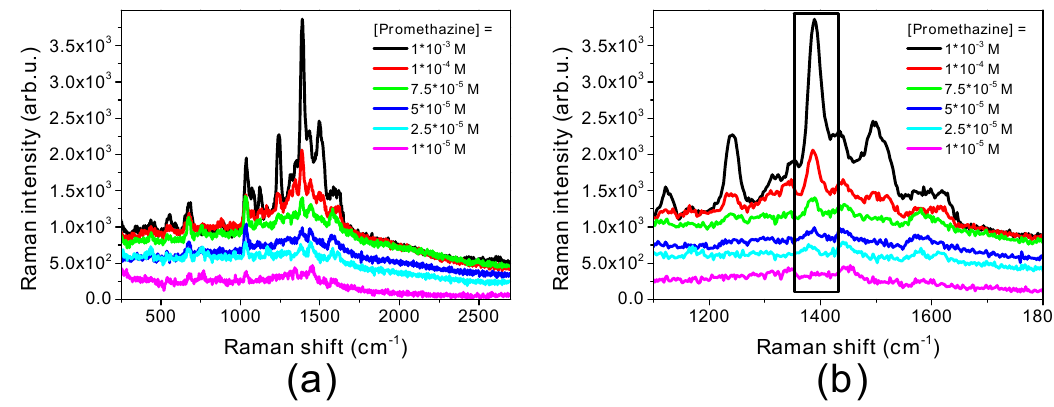
Figure 4. SERS detection limit for promethazine in the presence of Au@Ag@AuNRs: ( a ) Raman spectra of promethazine at different concentrations; ( b ) magnification of promethazine Raman signal at 1389 cm − 1 .